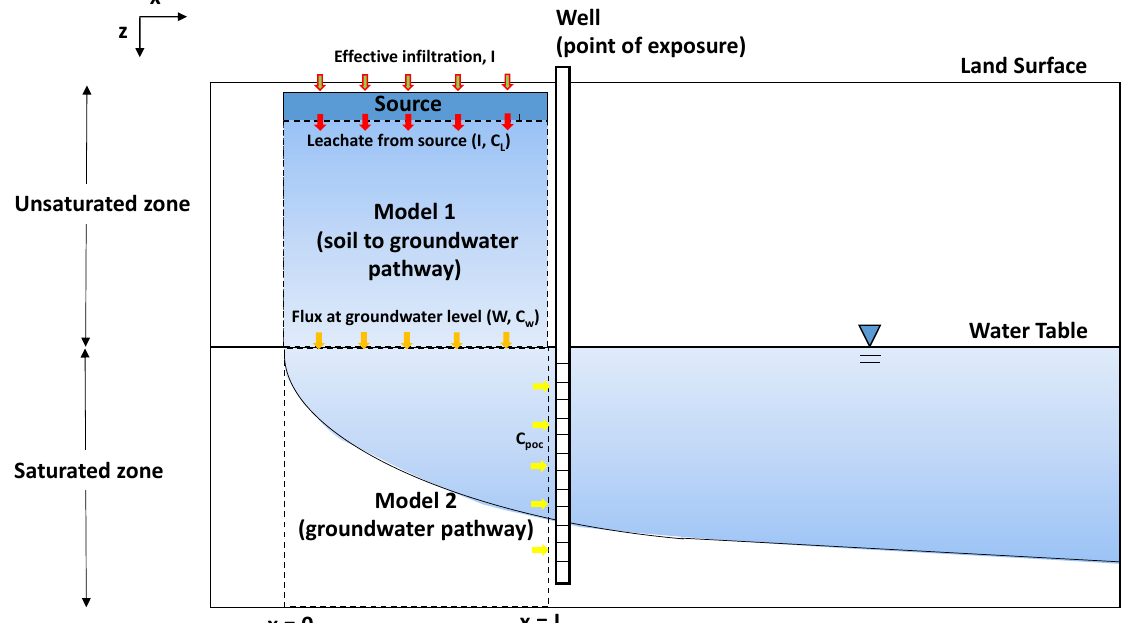
Figure 2. Schematic diagram for a contaminated site considering fate and transport in the unsaturated zone and the saturated aquifer underneath the source zone.